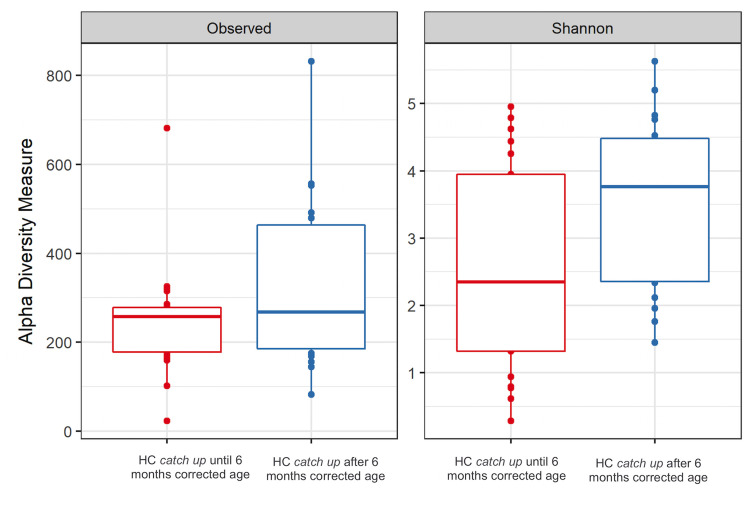
Alpha diversity measurements of meconium microbial communities from preterm infants comparing head circumference (HC) catch up until or after 6 months of corrected age.The left panel presents the number of observed Operational Taxonomic Unities (OTUs) (p-value = 0.225). The right panel presents the Shannon microbial index of diversity (p-value = 0.045). Boxes span the first to third quartiles; the horizontal line inside the boxes represents the median. Whiskers extending vertically from the boxes indicate variability outside the upper and lower quartiles, and single circles indicate outliers.